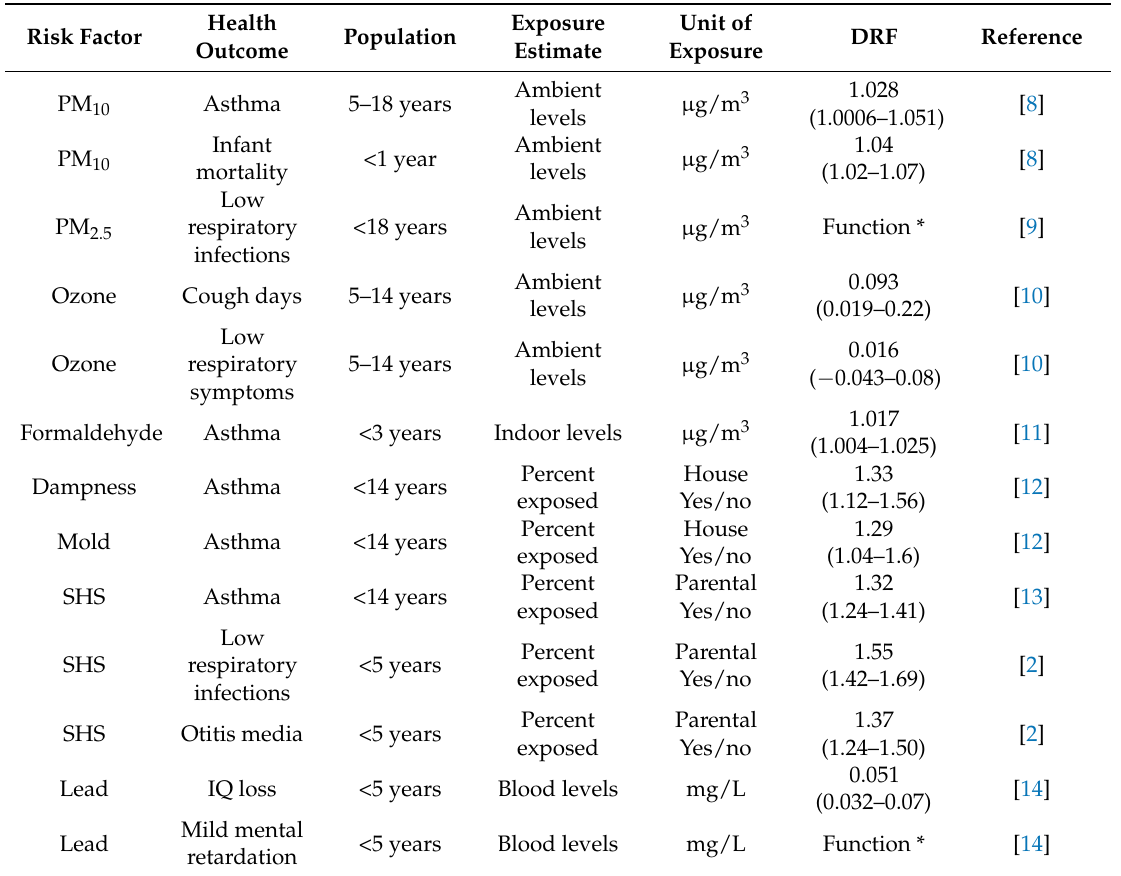
Table 1. Exposures, health outcomes and dose response functions included in the